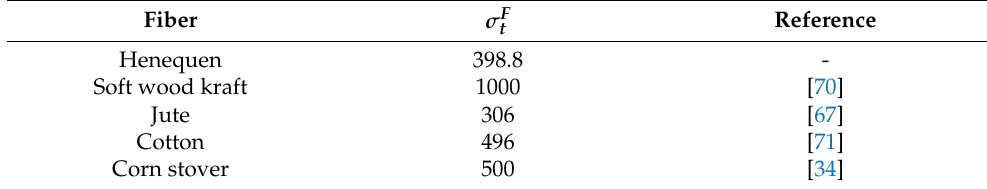
Table 6. Comparison of intrinsic tensile strength values of natural